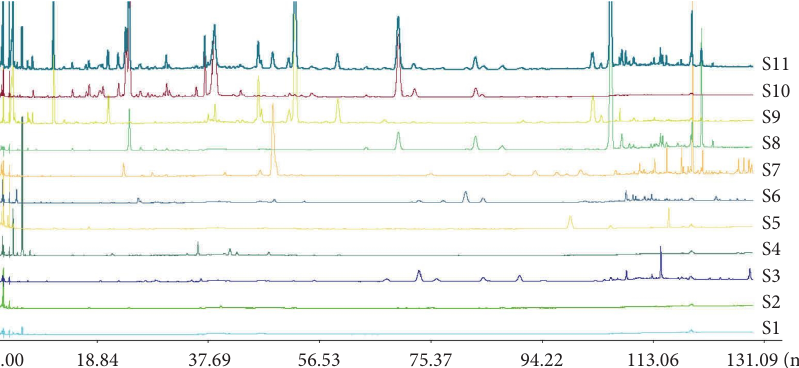
Figure 5: Matching graph of chromatogram between yinqiao powder and single drug. S 1. Phragmitis Rhizoma , S 2. Platycodonis Radix , S 3. Schizonepetae Spica , S 4. Lophatheri Herba , S 5. Sojae Semen Praeparatum , S 6. Menthae Haplocalycis Herba , S 7. Glycyrrhizae Radix et Rhizoma , S 8. Arctii Fructus , S 9. Forsythiae Fructus , S 10. Lonicerae Japonicae Flos , S 11. Yinqiao